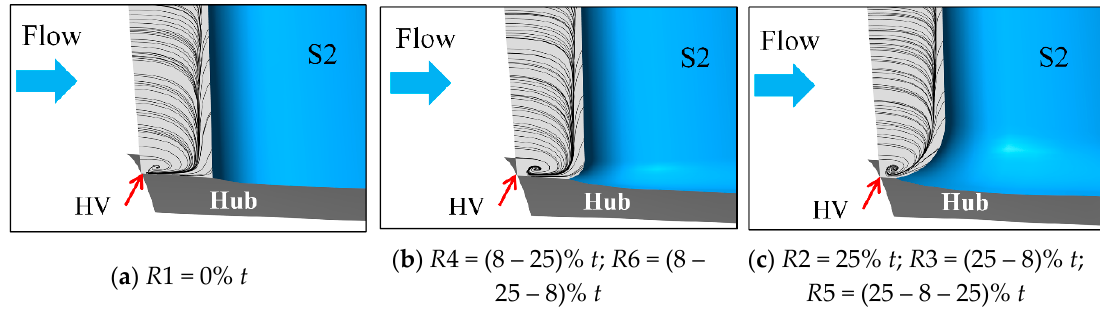
Figure 9. Horseshoe vortex structure at the leading edge of S2.